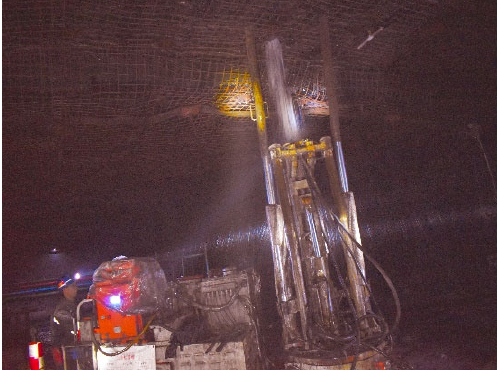
Figure 18. Large ‐ diameter borehole layout (net section).